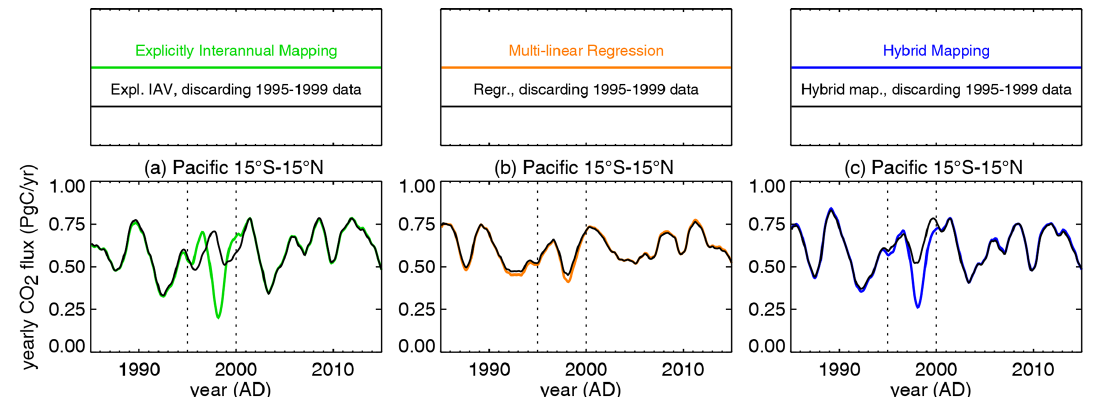
Figure 5. Interannual variations in the sea–air CO 2 flux in the tropical Pacific estimated by the explicitly interannual mapping (a) , the multi- linear regression (b) , and the hybrid mapping (c) , using either all p CO 2 data (base cases, colour) or all data but the ones during 1995–1999